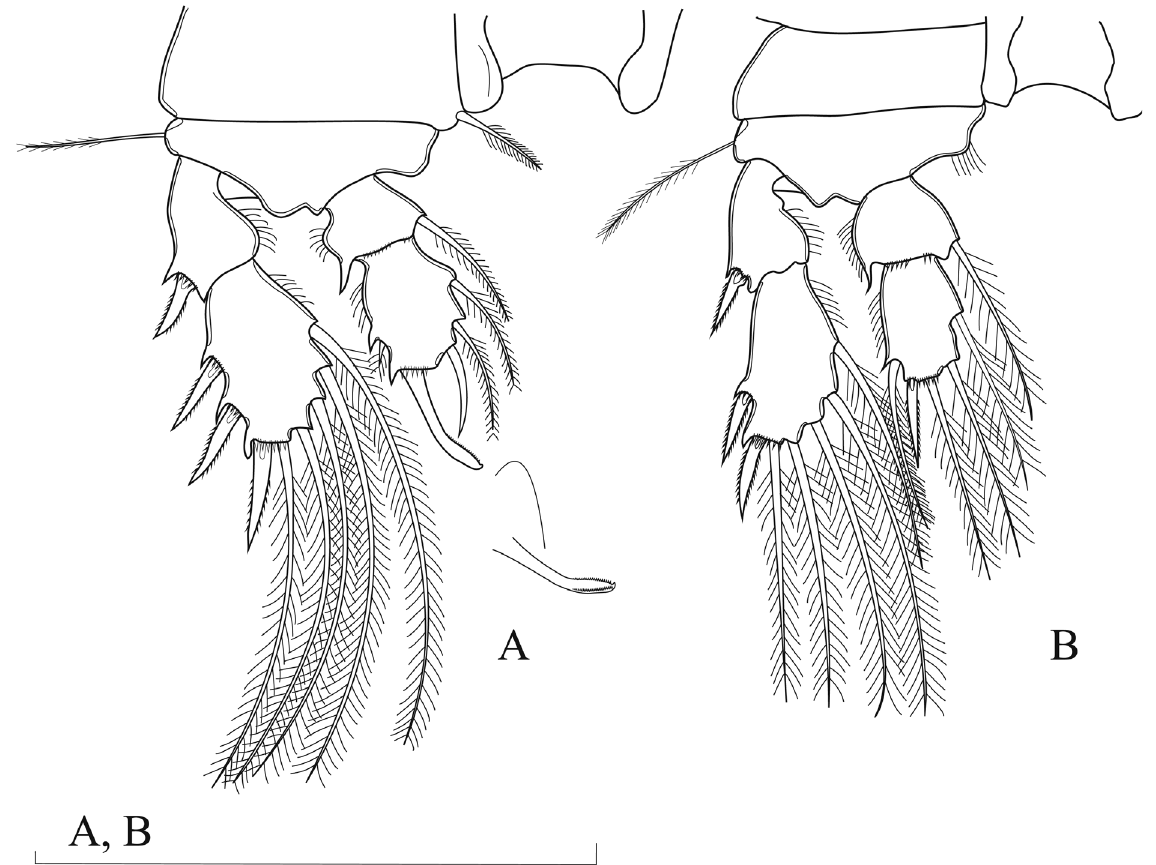
Fig. 5. Siamcyclops cavernicolus gen. et sp. nov., allotype, ♂. A . P3. B . P4. Scale bar: 100